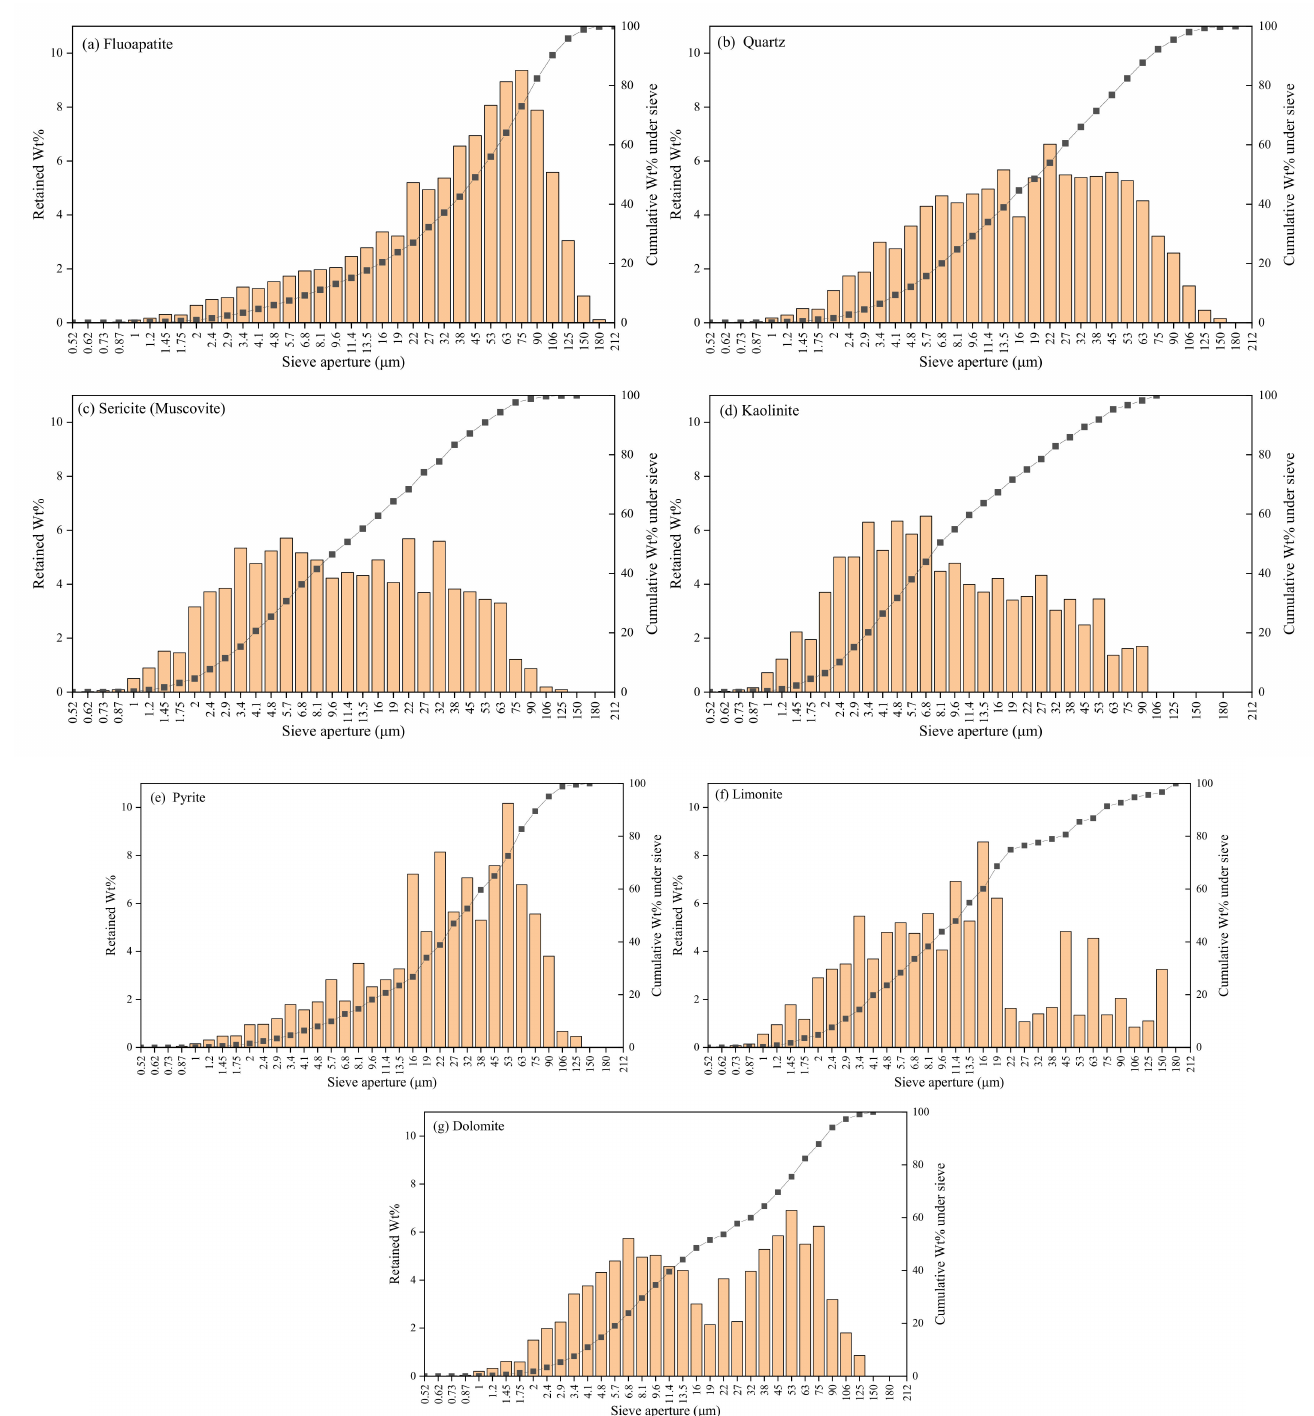
Figure 10. Grain size statistics of target minerals and main gangue minerals: ( a ) fluorapatite, ( b ) quartz, ( c ) sericite (muscovite), ( d ) kaolinite, ( e ) pyrite, ( f ) limonite, and ( g )